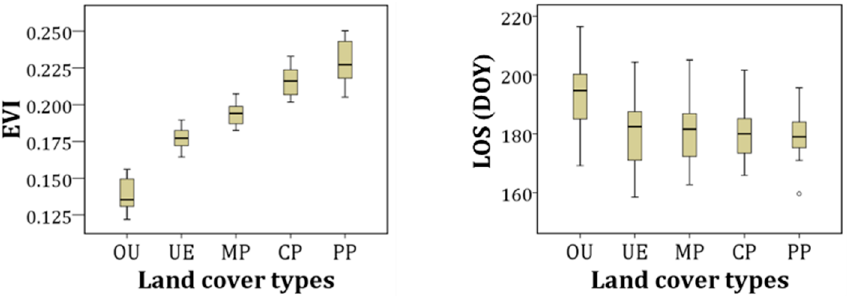
Figure 4. Statistical feature values of the five land cover types for enhanced vegetation index (EVI) and the length of season (LOS) during 2000 to